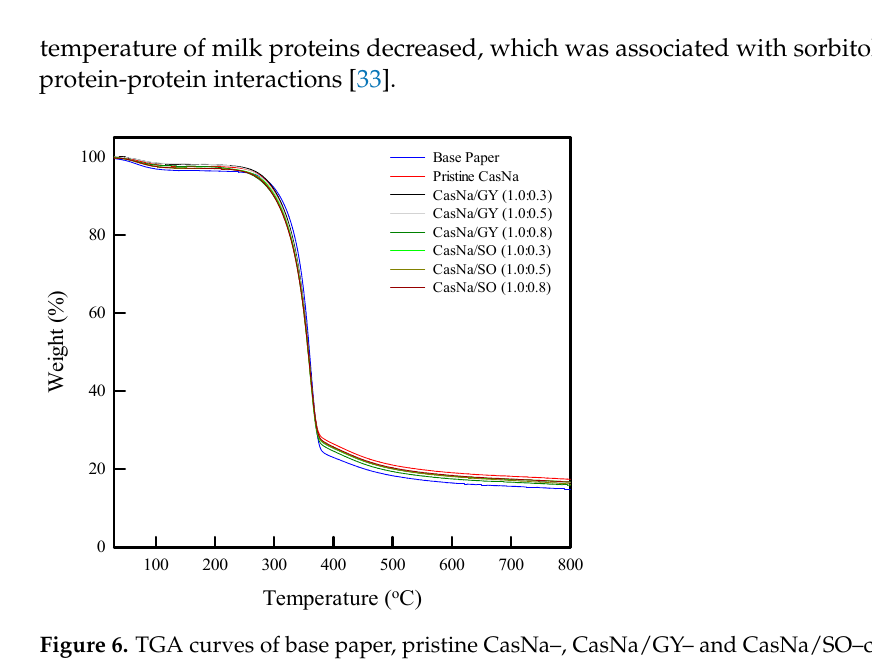
Figure 6. TGA curves of base paper, pristine CasNa–, CasNa/GY– and CasNa/SO–coated